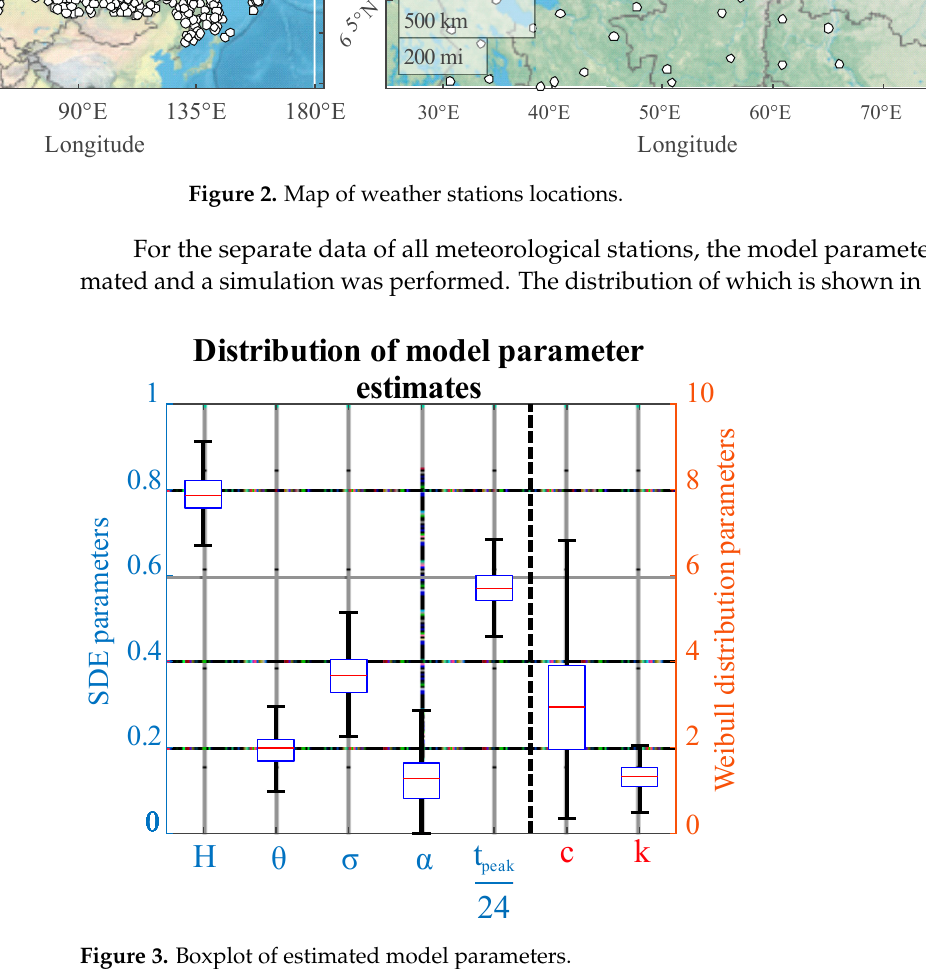
20 years of observations were used in the